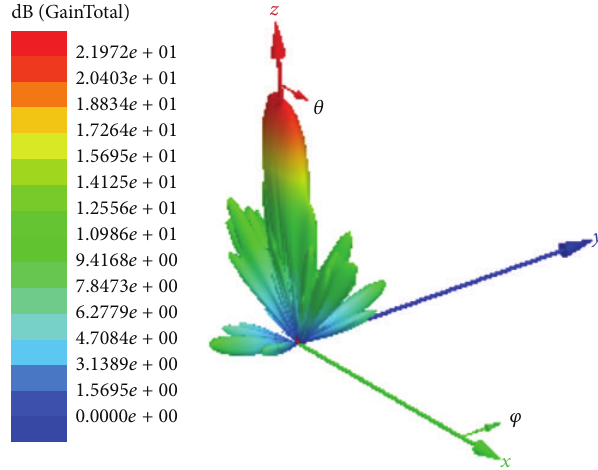
Figure 5: Simulated 3D total gain pattern of the antenna at 5.85 GHz.